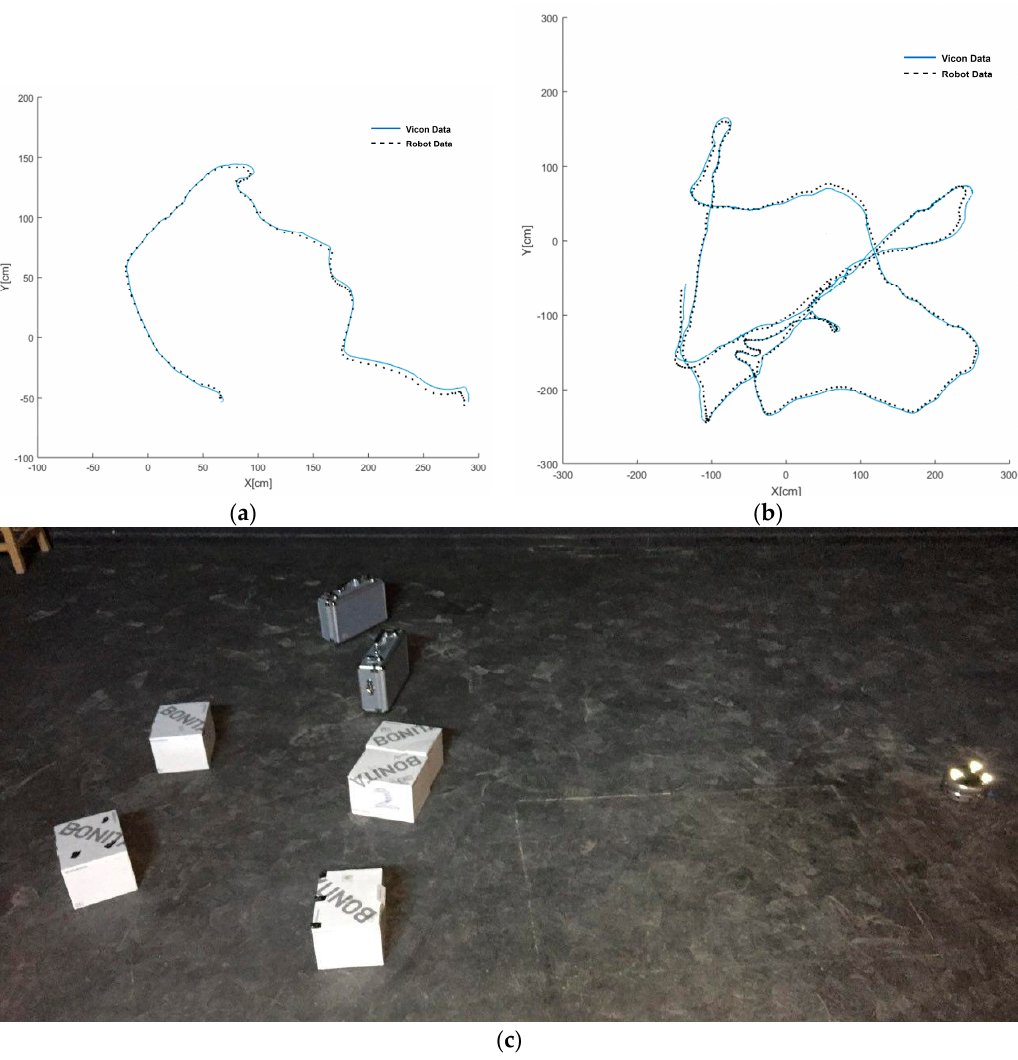
Figure 4. Validating the accuracy and robustness of the implemented robot self-localization system: ( a ) a short and simple navigation path; ( b ) a long and complicated navigation path; ( c ) a snapshot of the testing environment under the VICON system.